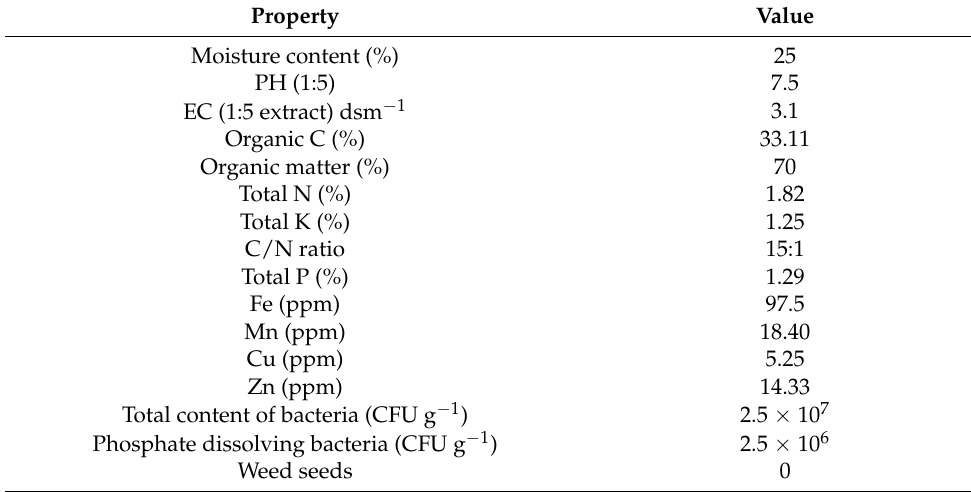
Table 2. Chemical properties of applied